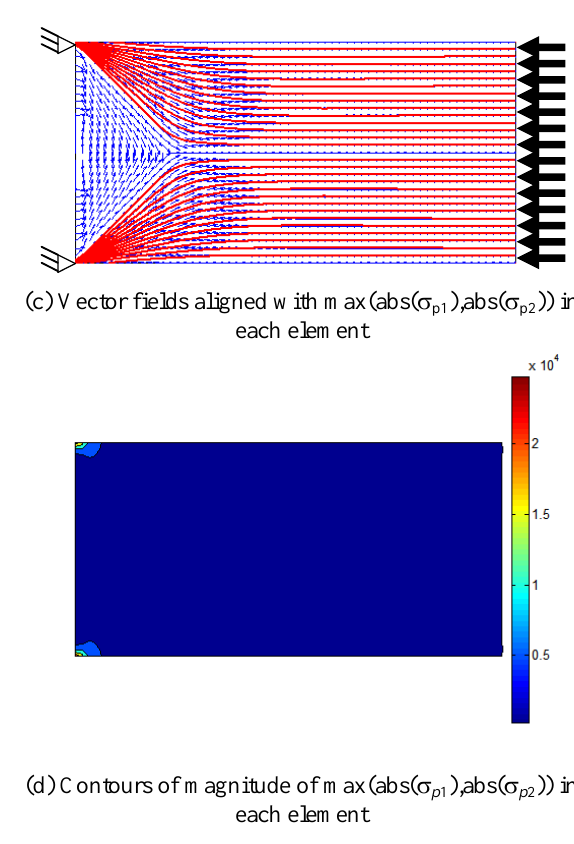
Fig. 17. Load paths based on principal stresses with dis- tributed loading in the horizontal direction